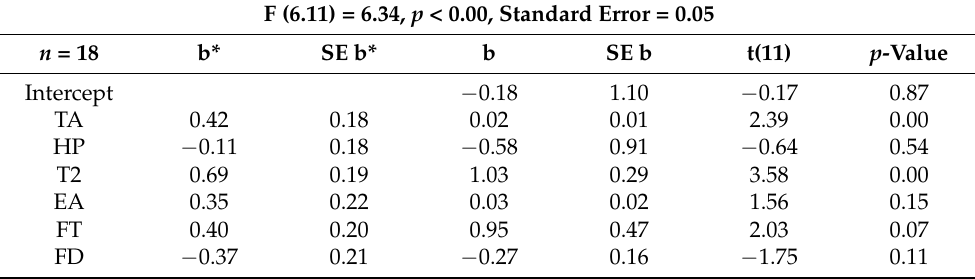
Table 5. Regression analysis for the flight